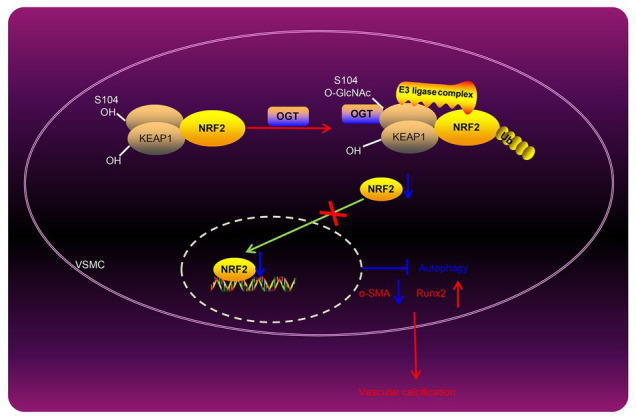
OGT enhances KEAP1 glycosylation leading to NRF2 degradation and inhibits VSMC autophagy, thereby promoting high phosphate-induced VC in CKD. In high phosphate-induced VSMCs, the expression of OGT and KEAP1 is elevated. OGT elevates glycosylation at KEAP1 S104 and then accelerates the degradation and ubiquitination of NRF2 to reduce NRF2 expression and to prevent its translocation into nuclei. At this point, calcification is facilitated in VSMCs due to promoted the expression of Runx2 as well as inhibited α-SMA expression and autophagy of cells.